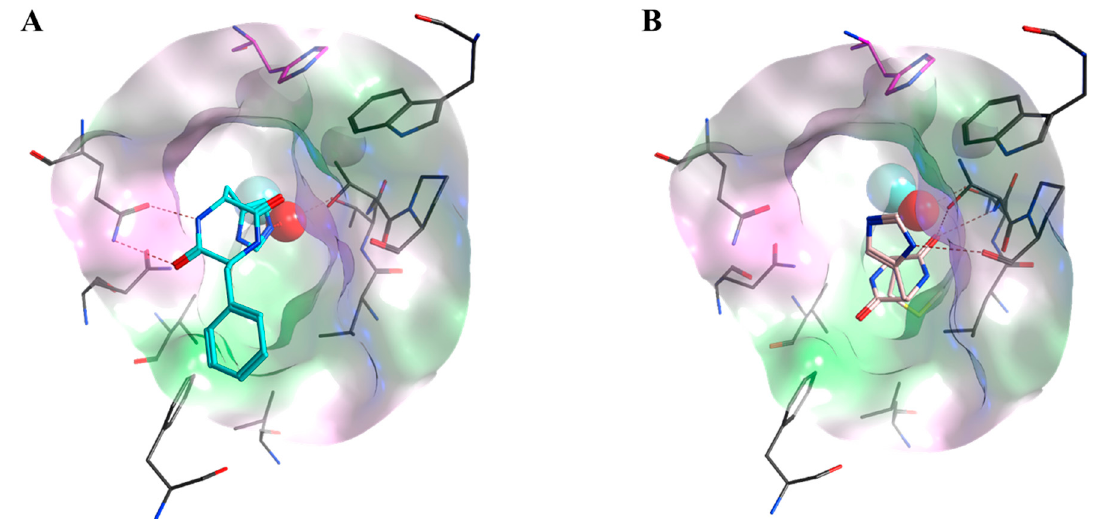
Figure 4. Representative docked poses of compounds 7 ( A ) and 8 ( B ) in the active site of hCA VII. The proton shuttle His66 is shown in magenta.